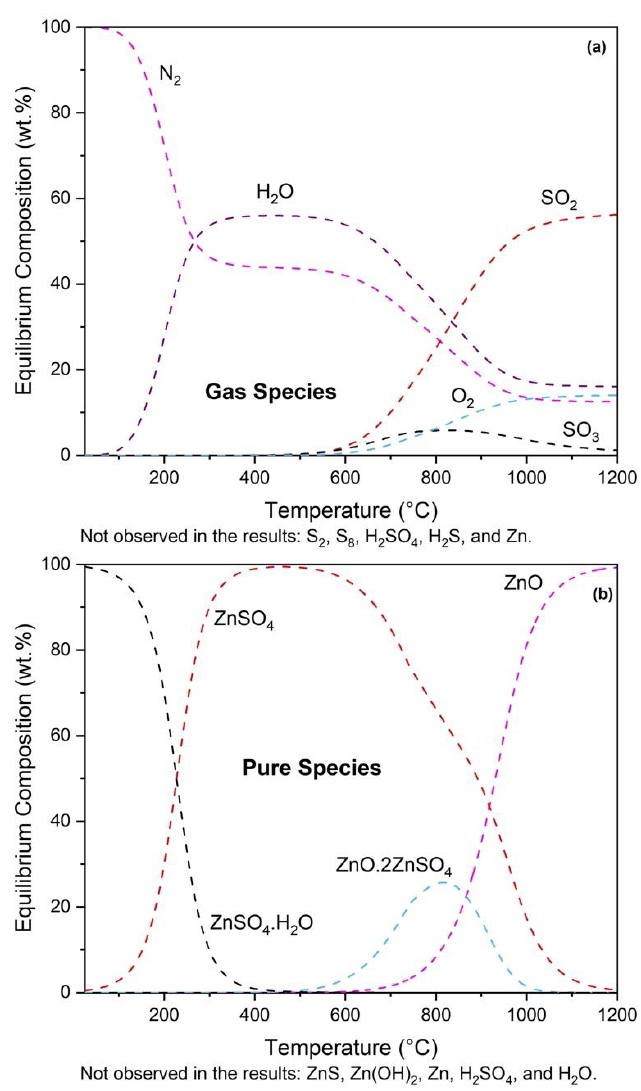
Figure 2. Equilibrium compositions for ZnSO 4 · H 2 O thermal decomposition: ( a ) gas-phase behavior; ( b ) pure species behavior.